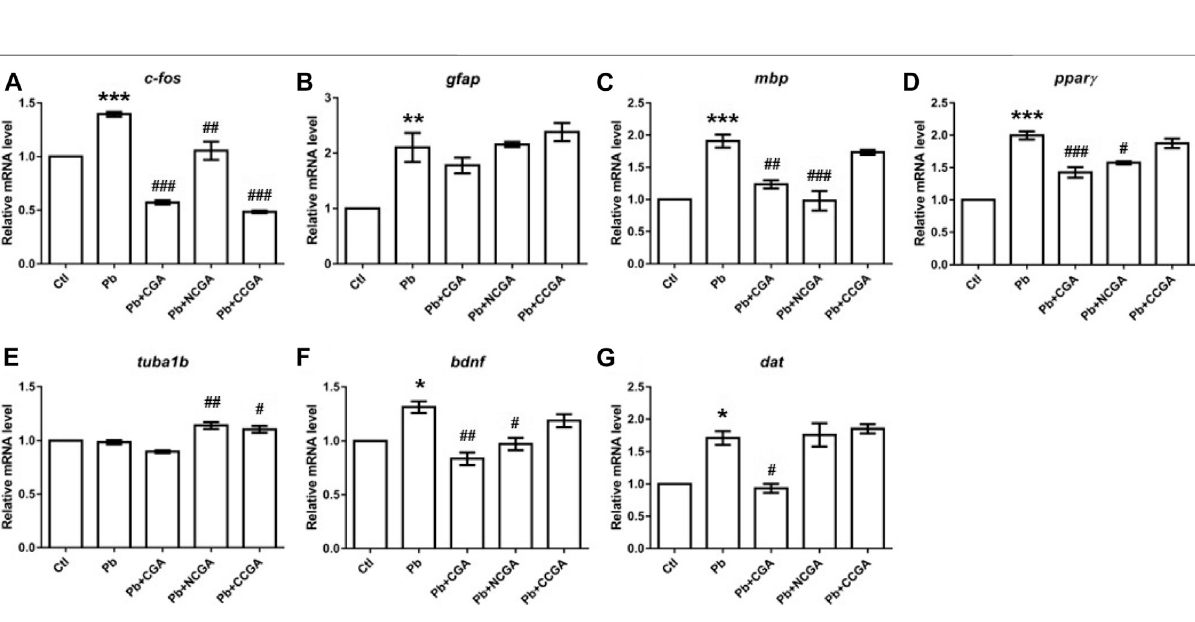
Frontiers in Molecular Biosciences |